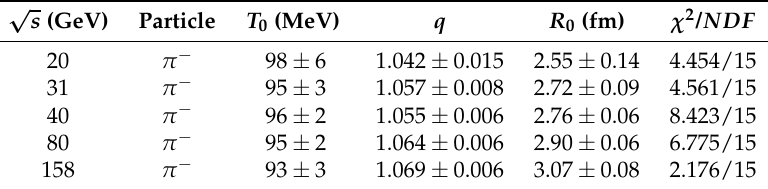
Table 4. The extracted values of T 0 , q , R 0 and χ 2 / NDF parameters, using the data published in [14] for pp collisions with the NA 61 Collaboration.